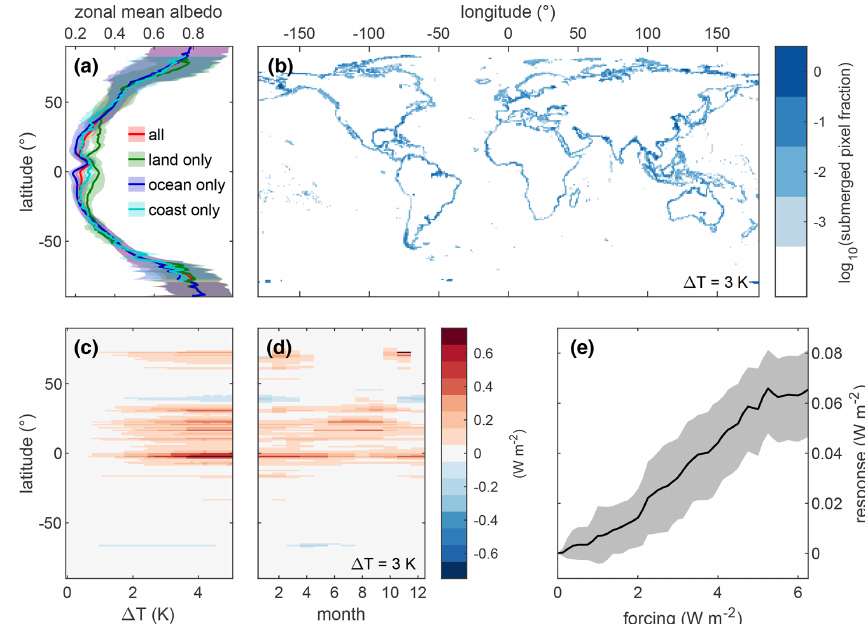
Figure 1. (a) Annual mean, zonal mean planetary albedo as a function of latitude, for the different classes of pixels (see text). Shading indicates 1 standard deviation of the monthly means. (b) Increase in the fraction of pixel area that is below local sea level at (cid:49)T = 3K. (c) Zonal mean, annual mean radiative forcing change resulting from sea-level induced albedo change as a function of (cid:49)T and latitude. (d) As in (c) , but as a function of month and latitude, at (cid:49)T = 3K. (e) Global mean, annual mean response of the forcing resulting from sea-level induced albedo change as a function of the forcing required to reach the given (cid:49)T ; black line indicates best estimate, gray shading indicates 1 standard